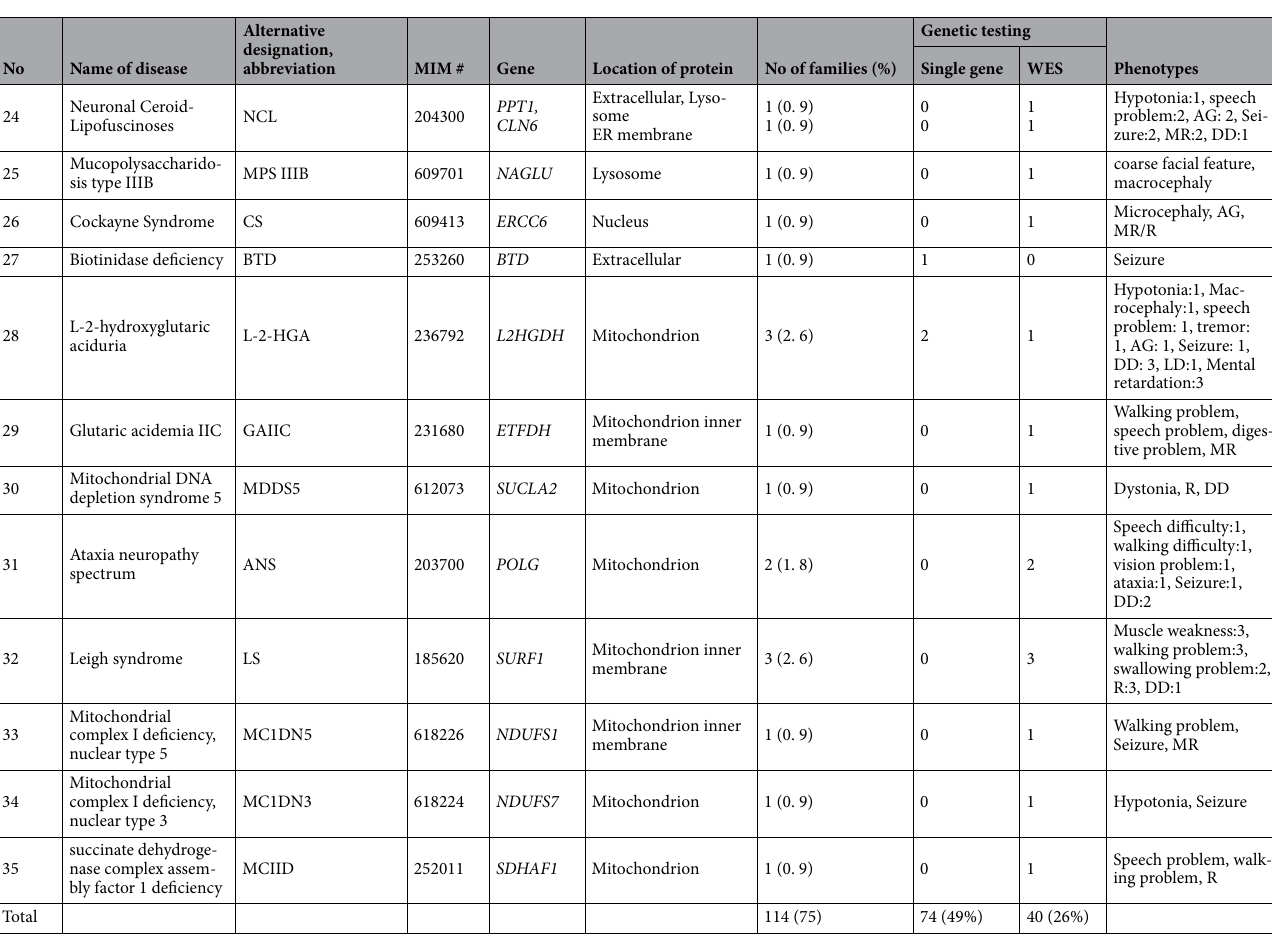
Table 1. The distribution of the leukodystrophies and genetic leukoencephalopathies based on single gene analysis and WES/panel based gene sequencing in 114 positive patients in the studied